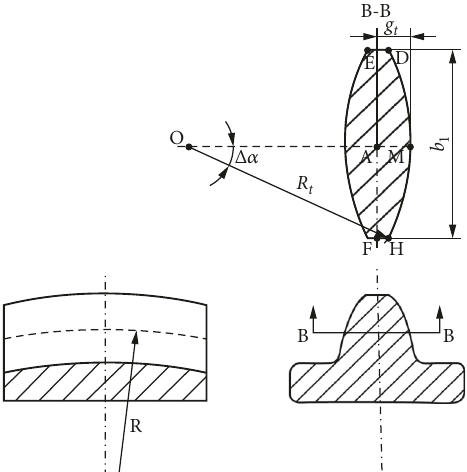
Figure 5: Schematic diagram of the outer tooth profile surface of the drum tooth